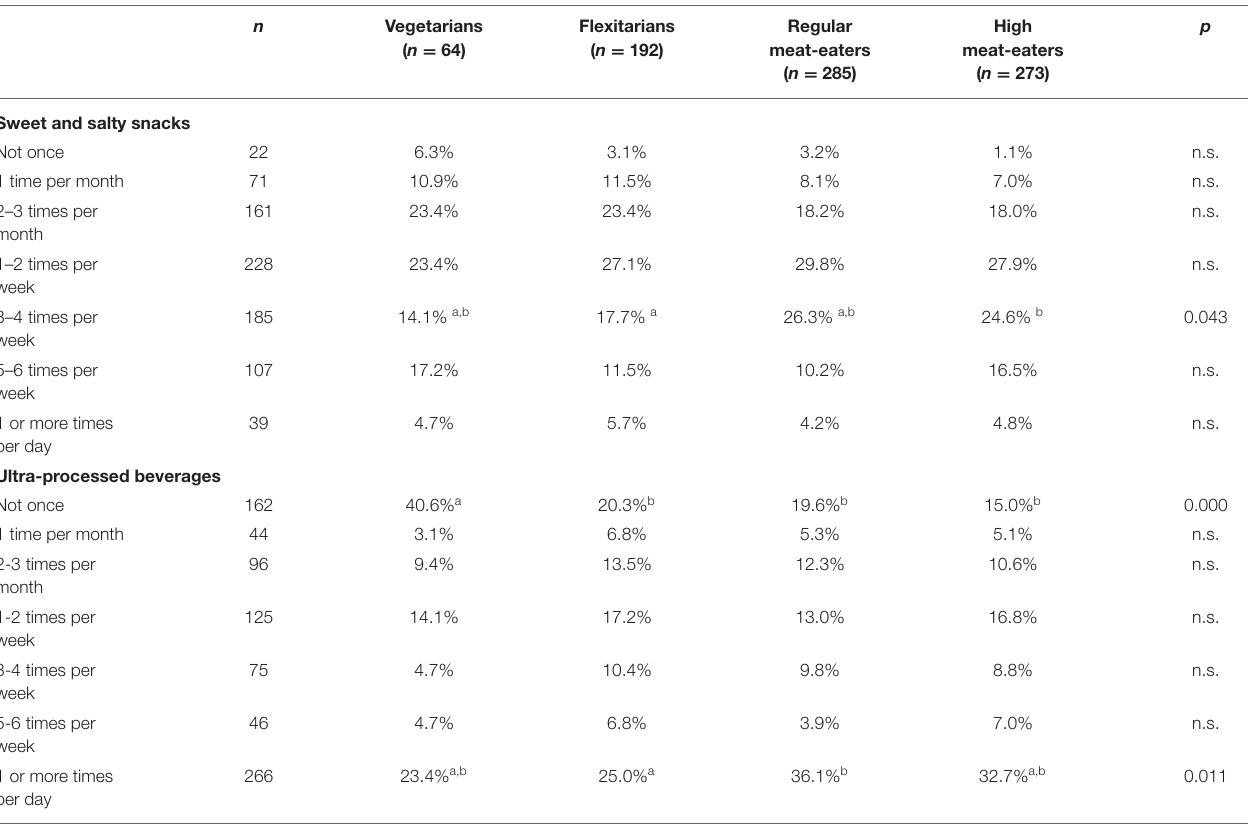
TABLE 5 | Consumption of sweet and salty snacks and ultra-processed beverages among dietary groups [vegetarians (no meat), flexitarians ( ≤ 1 × meat/week), regular eat-eaters ( ≤ 7 × meat/week), high meat-eaters ( > 1 × meat/day)]. n Vegetarians Flexitarians Regular High ( n = 64) ( n = 192) meat-eaters